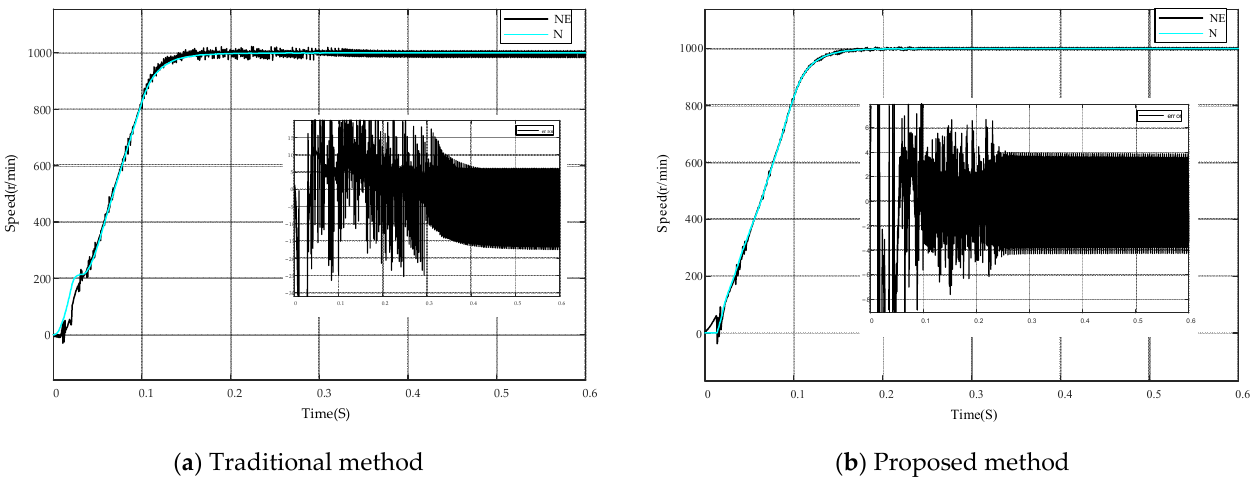
In Figure 5, the motor speed is 1000 r/min. After a stable operation, the speed estima- tion error obtained by using the traditional method is 10 r/min, while the speed estimation error obtained by using the proposed method is only 4 r/min.